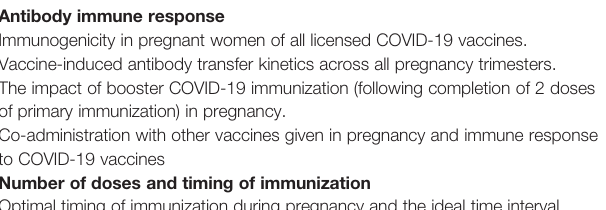
TABLE 5 | Consensus on priorities for future research related to ef fi cacy and effectiveness of immunization against SARS-CoV-2 in pregnancy. Vaccine effectiveness across different populations of pregnant women Vaccine effectiveness against new variants of concern Vaccine effectiveness studies with non-mRNA formulations (e.g. inactivated vaccines, non-replicating vectors). Ideal timing of immunization and number of doses to provide protection to the pregnant women and their